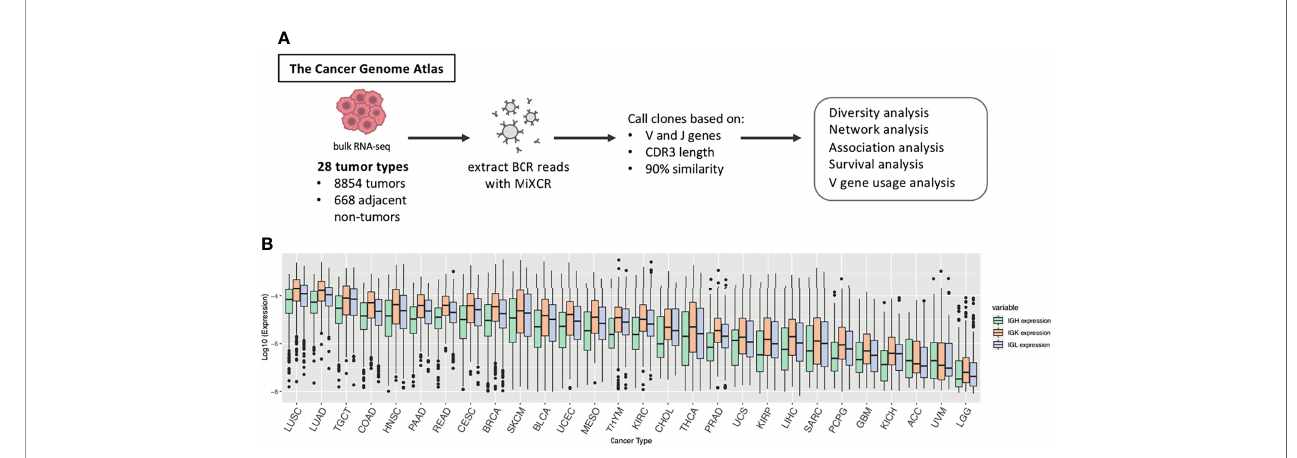
FIGURE 1 | Study overview. (A) BCR reads were extracted from TCGA RNA-seq data across 28 tumor types using MiXCR and we called clones based on sequences having the same V and J gene, the same CDR3 length, and at least 90% sequence similarity. We then performed diversity analysis, network analysis, association analysis, survival analysis, and V gene usage analysis to investigate differences in the B cell immune repertoire across tumor types and between tumor and adjacent non-tumor samples. (B) Boxplots showing the log10 expression of IGH, IGK, and IGL. Expression is de fi ned as the number of reads for each chain divided by the total number of reads in the sample. The box plot depicts the median as well as the upper and lower quartiles, and the whiskers depict 1.5 times the interquartile